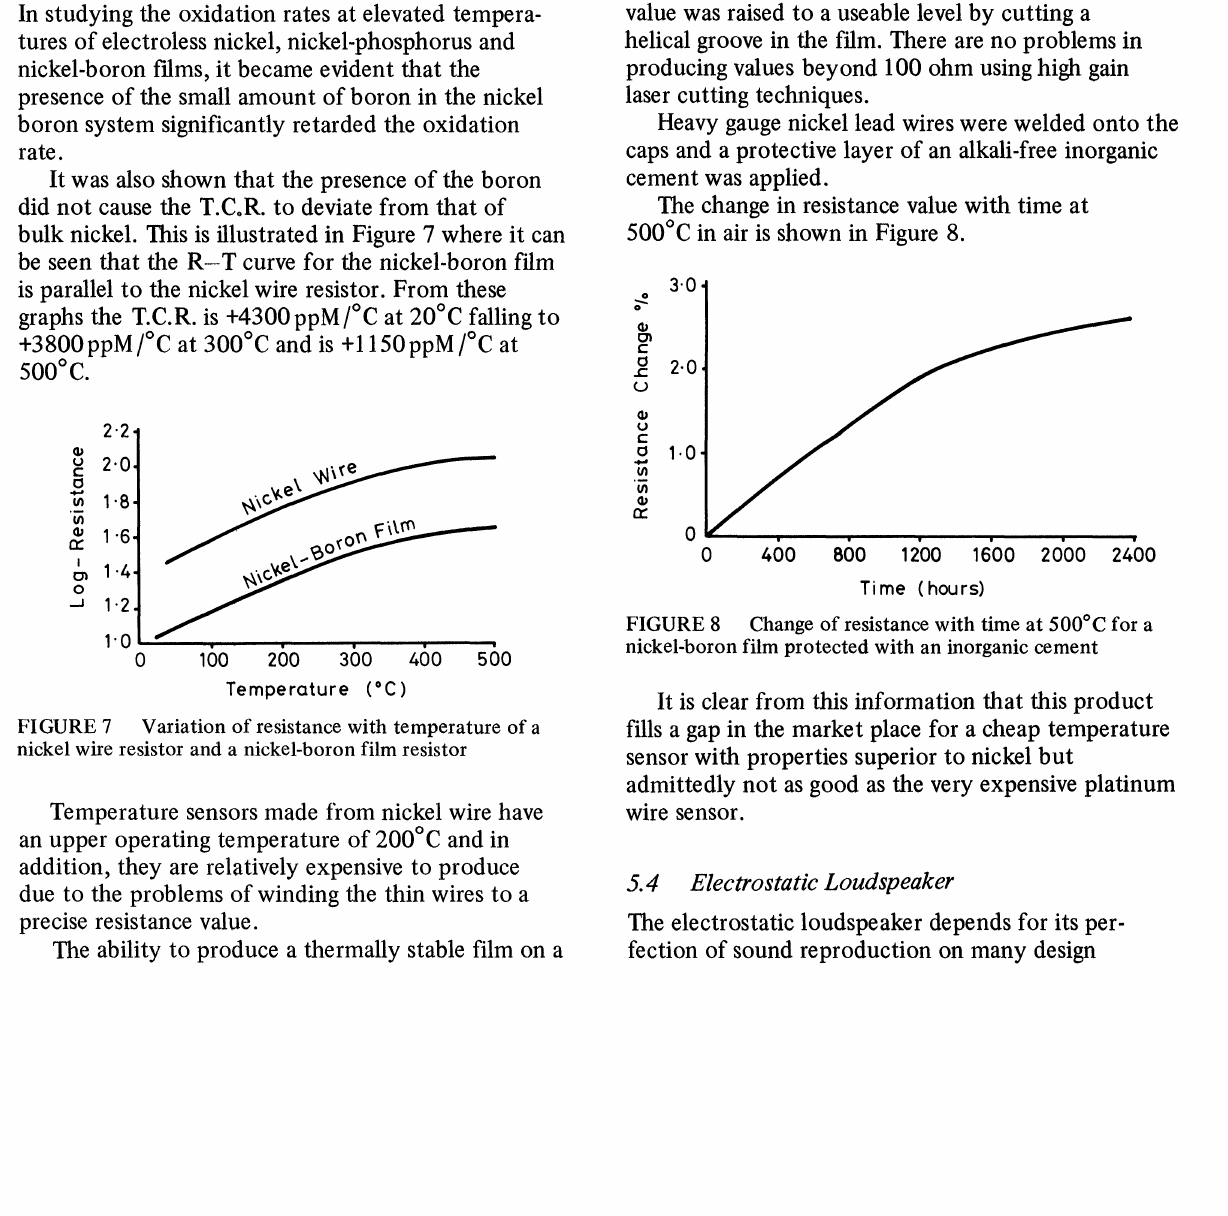
Change of resistance with time at 500C for a nickel-boron film protected with an inorganic cement It is clear from this information that this product fills a gap in the market place for a cheap temperature sensor with properties superior to nickel but admittedly not as good as the very expensive platinum wire